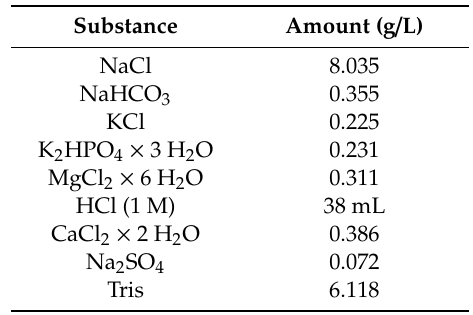
Table 1. List of substances used for the preparation of 1 L simulated body fluid (SBF). Substances were added to deionized water in the order given in the table. Afterwards, the pH of the solution was adjusted to pH 7.4 and the volume was filled up to 1 L using deionized water. Adapted with permission from [33]; Published by Springer Nature,